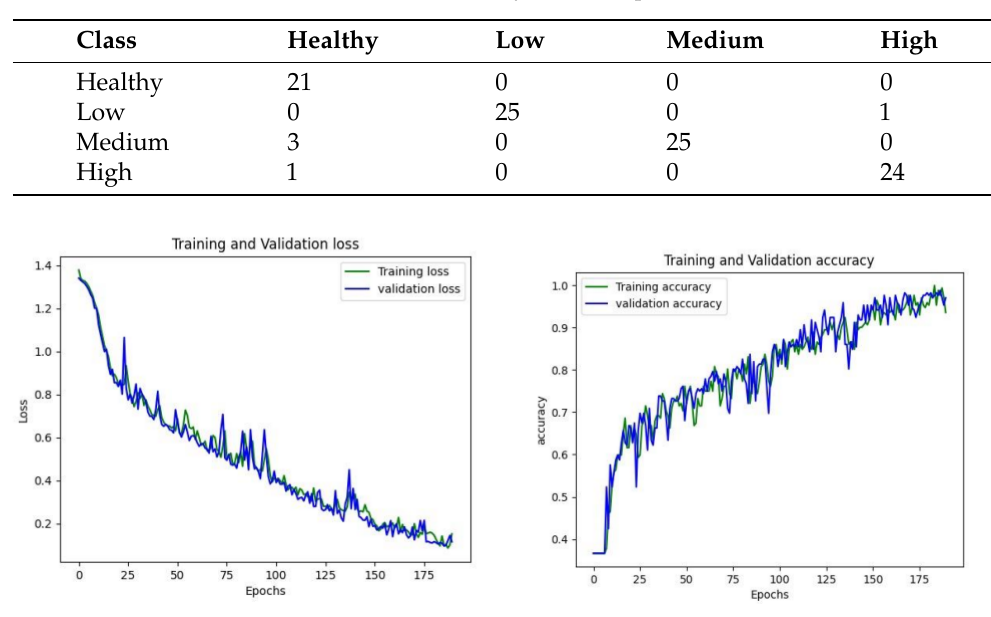
Table 3. Confusion matrices for all levels of severity of disease present in citrus fruits.